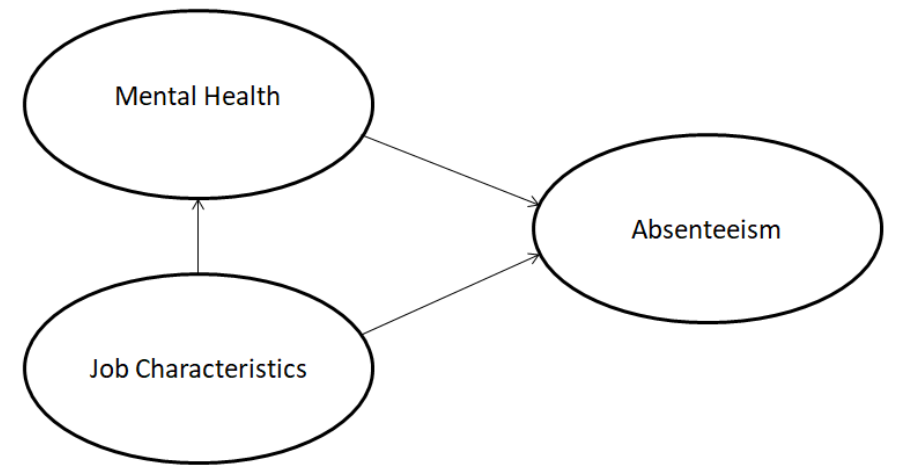
Figure 1. Conceptual framework.